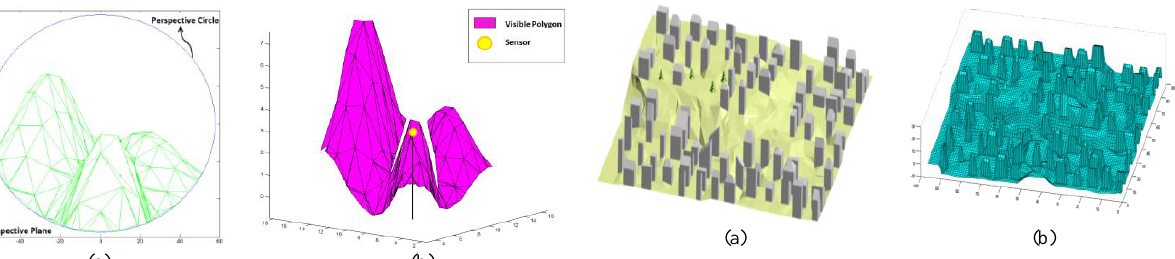
Figure 14. (a) The CityGML model; (b) DSM model with the spatial resolution of 2 m